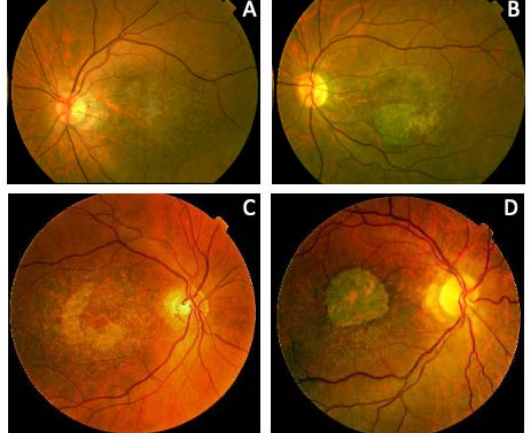
Figure 12. Family 5a (p.Arg195Leu) presents with CACD. ( A ) F5a-III-7 had whitish stippling only in the macular area. ( B ) F5a-III-10 had incipient macular atrophy as well. ( C ) F5a-III-2 had typical foveal preservation. ( D ) F5a-III-6 had total macular atrophy.